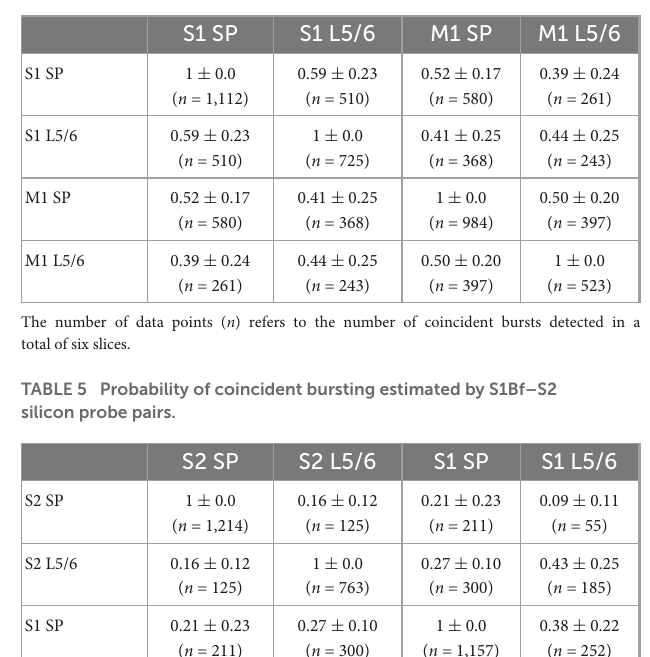
TABLE 4 Probability of coincident bursting estimated by S1Bf–M1 silicon probe pairs.